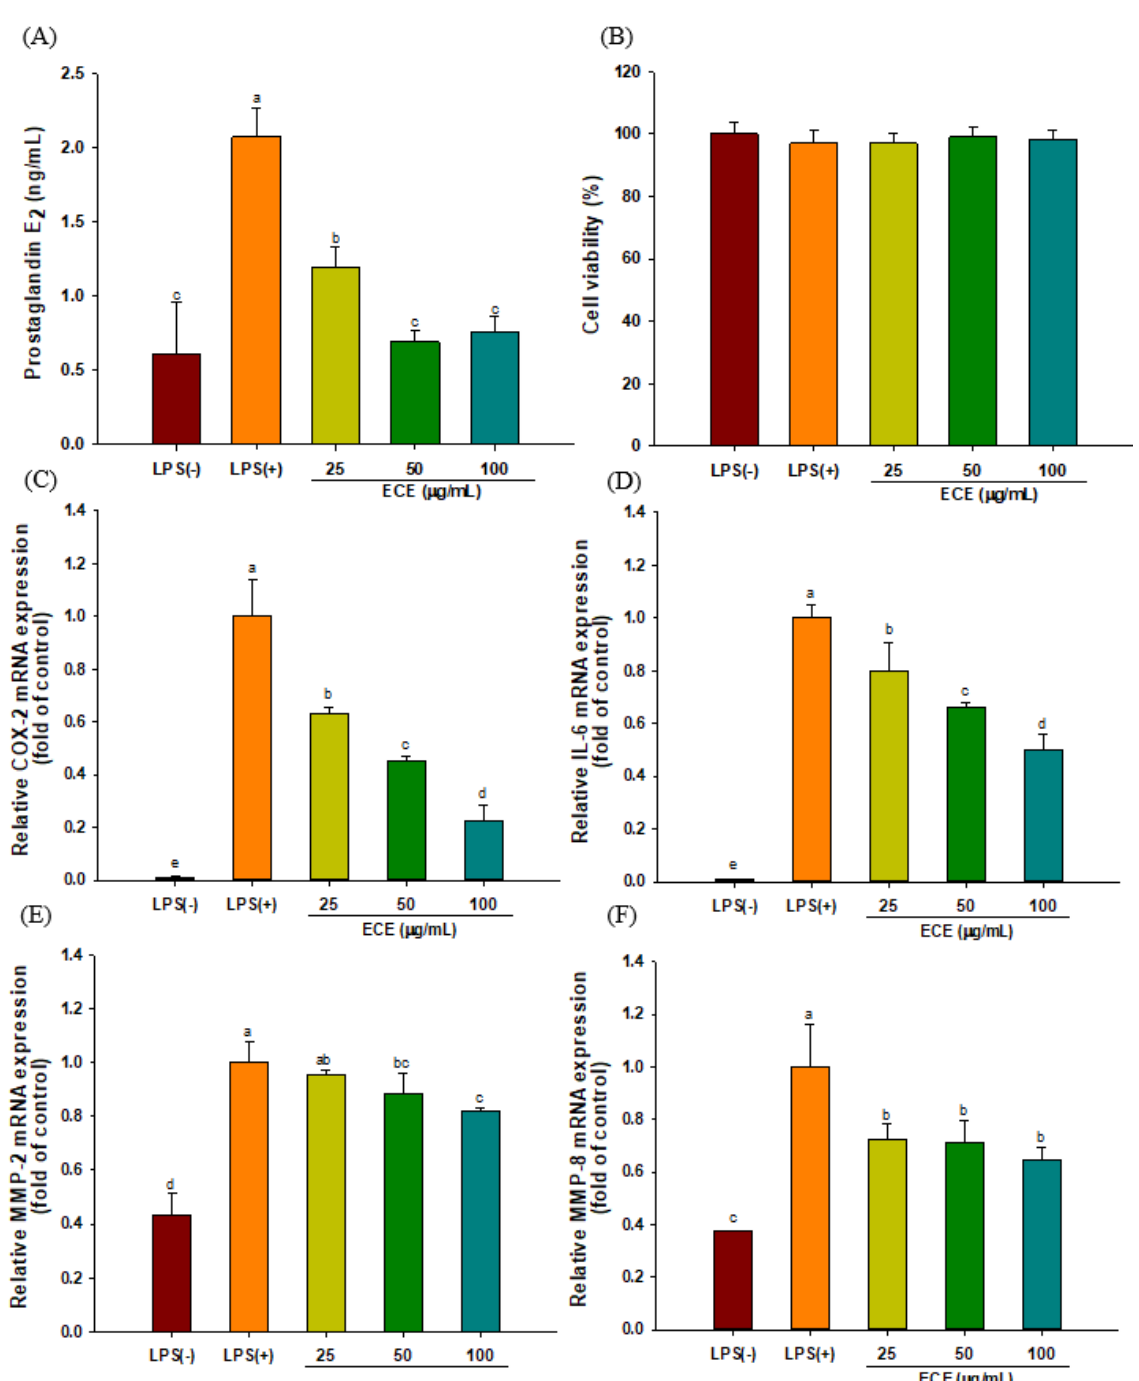
Figure 1. Effect of ECE treatment on ( A ) PGE 2 , ( B ) cell viability, ( C ) COX-2, ( D ) IL-6, ( E ) MMP-2, and ( F ) MMP-8 mRNA expressions in LPS-stimulated HGF-1 cells. Cells were incubated for 24 h in the presence of LPS (5 μg/mL) and ECE. Different letters (a–e) show significant difference ( p < 0.05). ECE: Ecklonia cava extract; PGE 2 : prostaglandin E 2 ; COX-2: cyclooxygenase-2; IL-6: interleukin-6; MMP-2: matrix metalloproteinases-2; MMP-8: matrix metalloproteinases-8; LPS: lipopolysaccharide; HGF: human gingival fibroblasts.